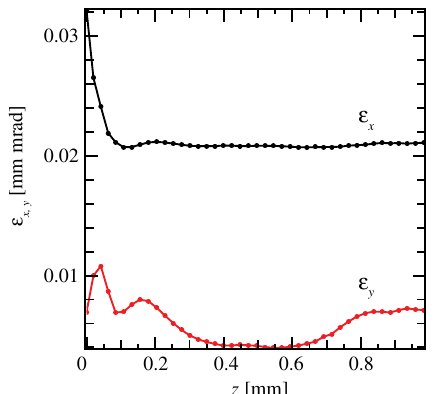
FIG. 9. The normalized emittance evolution in the laser polarization plane ϵ (black curve) and orthogonal to the laser x polarization plane ϵ (red curve). (Two-color ionization injection y parameters are the same as Fig.